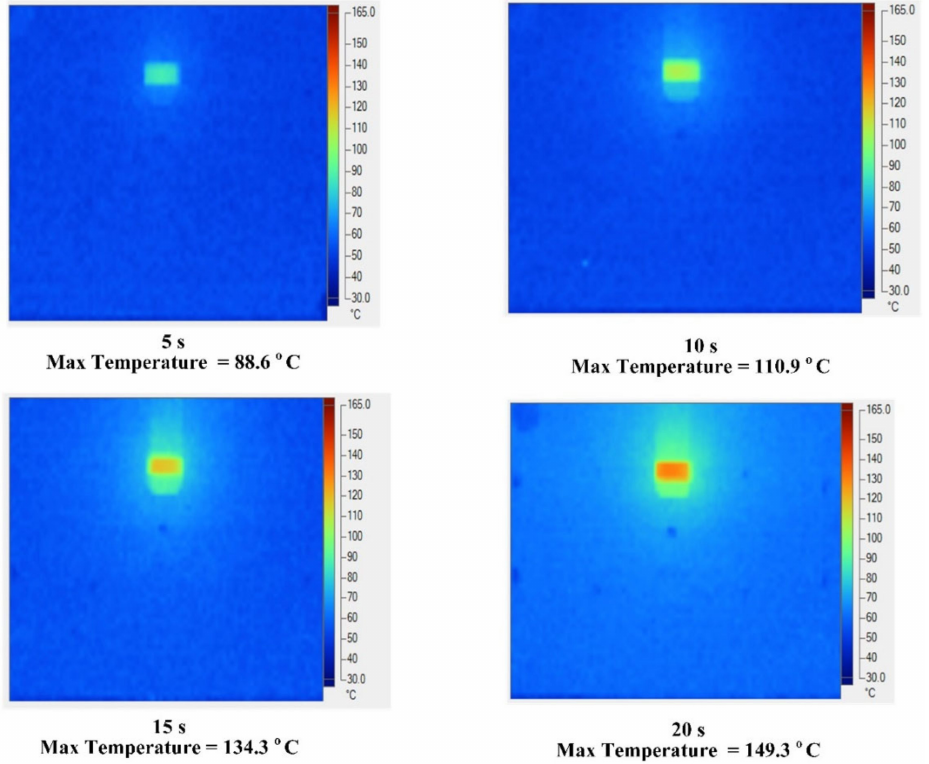
Figure 16. Temperature distribution of mold surface with a gas temperature of 400 ◦